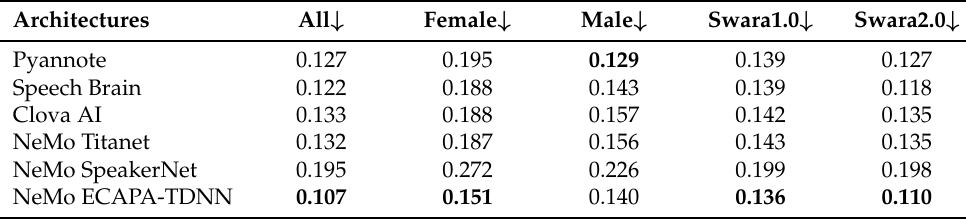
Table 3. Average inter-speaker cosine similarity across the different speaker embedding architectures and different speaker subsets. Arrows mark the direction of best performance. Best results are highlighted in